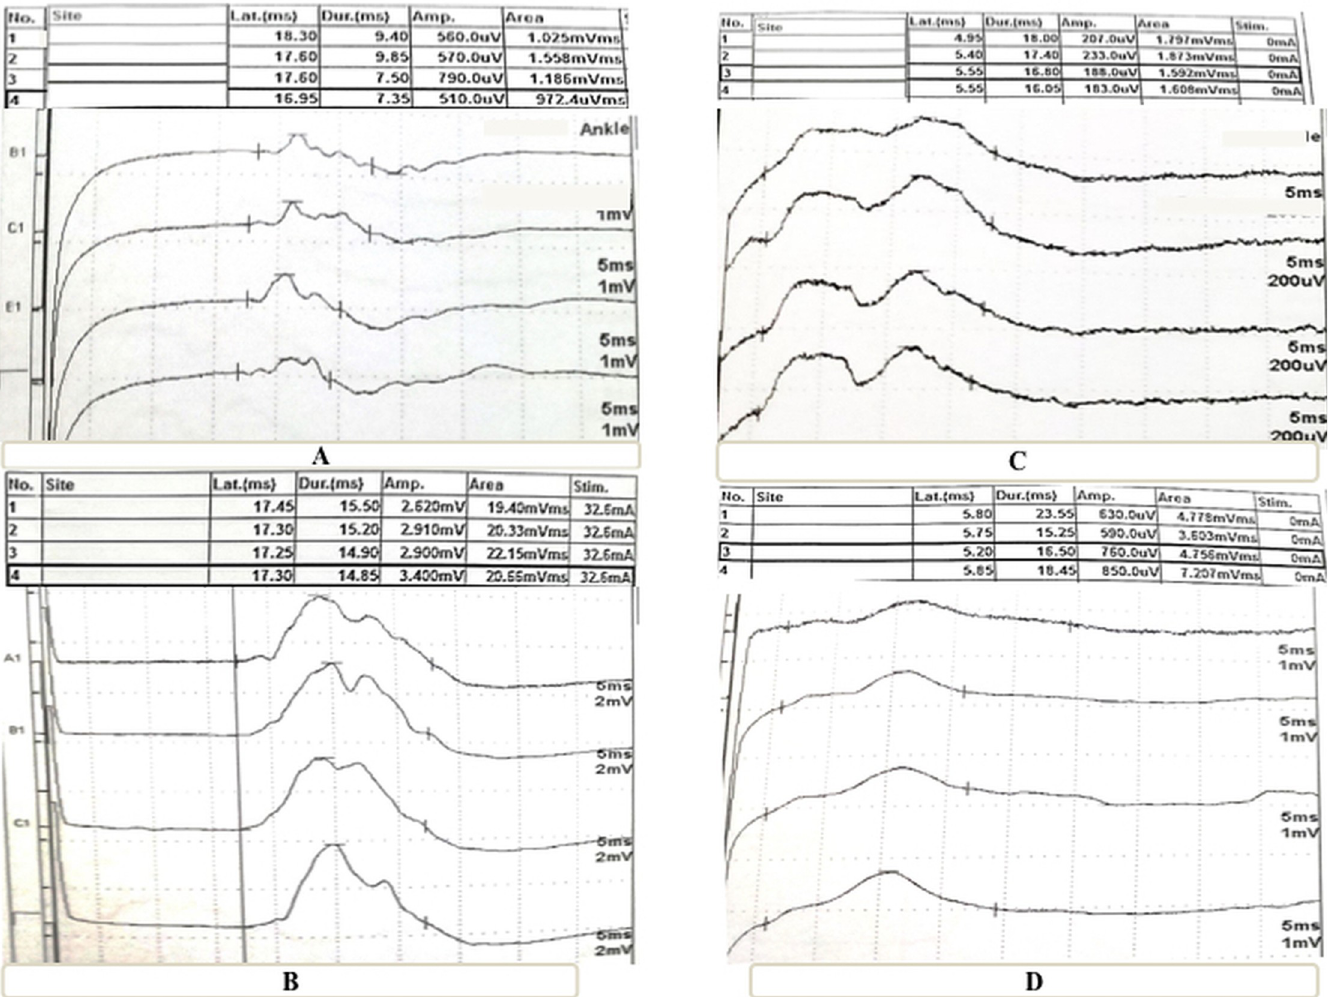
Fig 1. Demonstration example of CMEP and PMEP diaphragmatic signals in COPD and normal Subject. (A) CMEP of diaphragm in COPD patient noticing that there is delayed latency and low amplitude of the response versus Fig 1B which represents healthy subject; (C) PMEP of diaphragm in COPD patient with low amplitude of the response versus Fig 1D which represents healthy